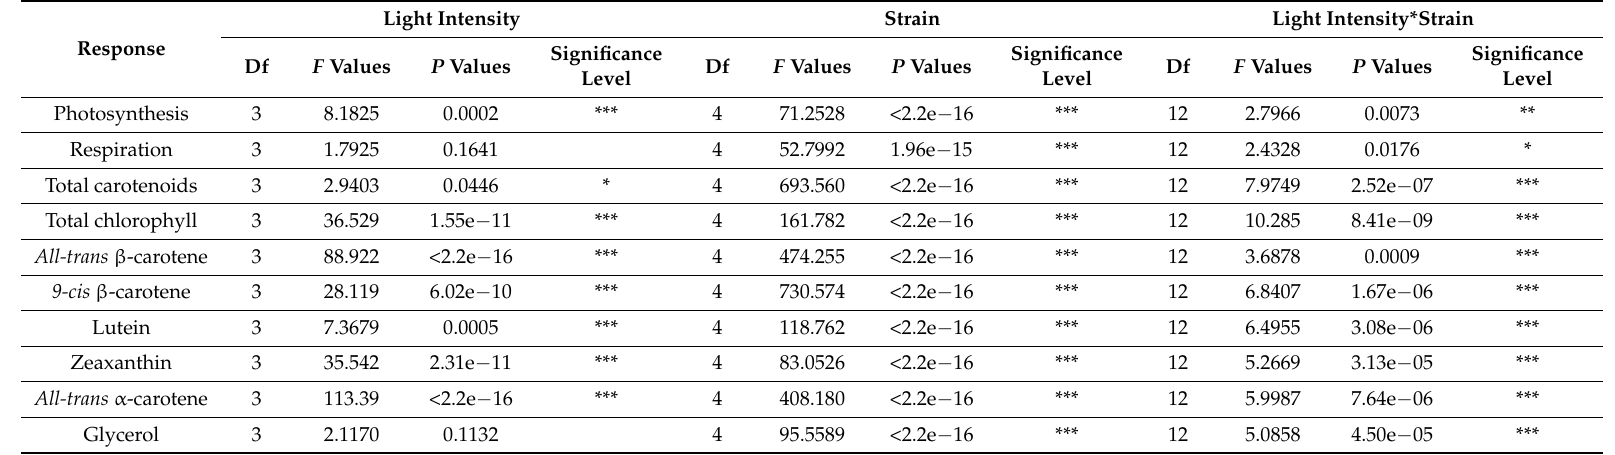
Table 1. Two-way ANOVA analysis of the responses of all examined variables (photosynthesis, respiration, doubling time, all-trans β -carotene, 9-cis β -carotene, glycerol, lutein, zeaxanthin, all-trans α -carotene, total carotenoids, total chlorophyll) to strain and light intensity and their interaction (Light intensity*Strain). The values of all observations were transformed by taking log function, square root function or reciprocal to fit linear models. Df: degrees of freedom; F values: variation between sample means; P values: significance levels and a star (*) indicates P ≤ 0.05, two stars (**) P ≤ 0.01 and three stars (***) P ≤